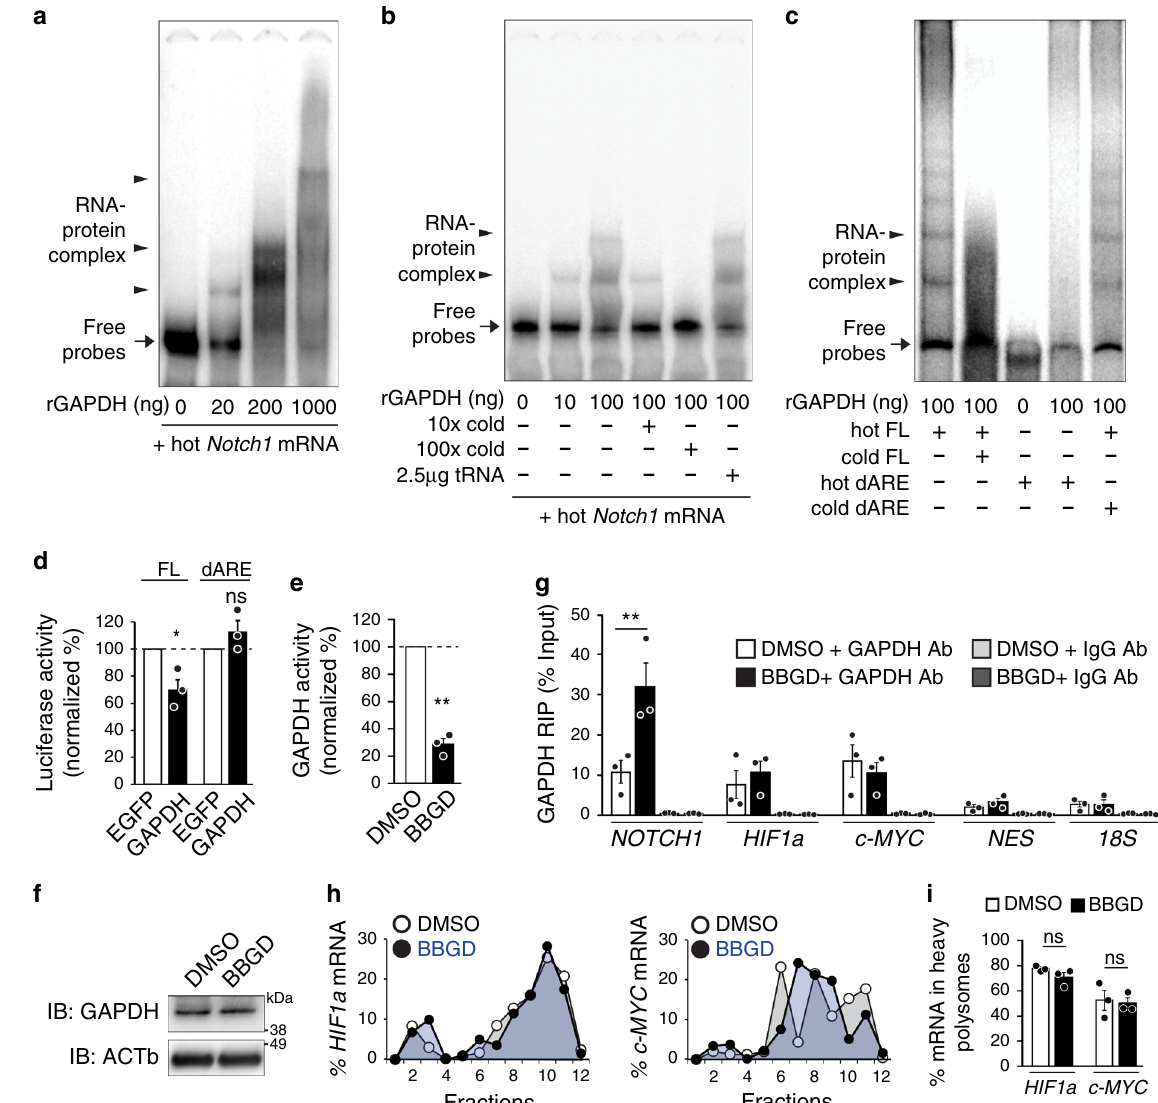
Fig. 4 GAPDH binds Notch1 mRNA 3 ʹ UTR in response to excessive methylglyoxal and regulates Notch1 translation. a – c REMSA was performed using the labelled (hot) full-length (FL) or AU-rich element-deleted (dARE) Notch1 3 ʹ UTR RNA probe in the presence of incremental amounts of recombinant GAPDH protein and the presence of unlabeled (cold) speci fi c or unspeci fi c RNA probes. Arrows and arrowheads indicate free RNA probes and RNA- GAPDH complexes, respectively. n = 3 experiments. d Luciferase activity from a reporter containing the full-length (FL) or AU-rich element-deleted (dARE) Notch1 3 ʹ UTR co-transfected with a plasmid expressing EGFP control or GAPDH in HEK293 cells. Fire fl y luciferase activity values were normalized to Renilla luciferase activity in the same samples. n = 3 experiments. e – i hNPCs were treated with DMSO or BBGD for 48 h. e GAPDH activity in the cell lysates. The same number of cells were seeded prior to treatment and the GAPDH activity was further normalized by total protein mass. n = 3 experiments. f Western blots probed for GAPDH and reprobed for ACTb as a loading control. n = 3 experiments. g qRT-PCR analysis of mRNA enrichment by RNA immunoprecipitation (RIP) with control IgG or an anti-GAPDH antibody (normalized to the total RNA input). n = 3 experiments. h qRT-PCR analysis of the relative distribution of the HIF1a and c-MYC mRNAs across all fractions from polysome pro fi ling. i Quanti fi cation of the relative enrichment of HIF1a and c- MYC mRNAs in the heavy polysome fractions. Each point corresponds to the value of each fraction normalized to the total HIF1a or c-MYC mRNA. n = 3 experiments. Data are presented as mean values ± SEM and analyzed using two-tailed, unpaired students t -test. ** p < 0.01, ns = p > 0.05. Source data and p -values are provided as a “ Source Data fi le ”